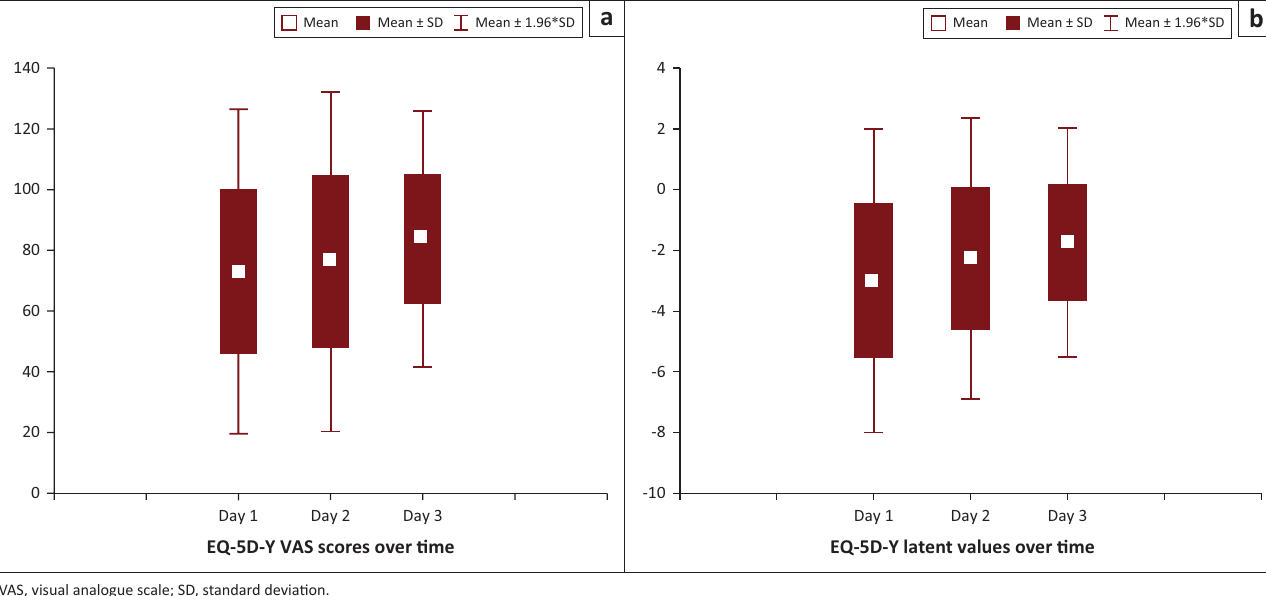
FIGURE 1: Box and whisker plot of children’s EQ-5D-Y scores over time.